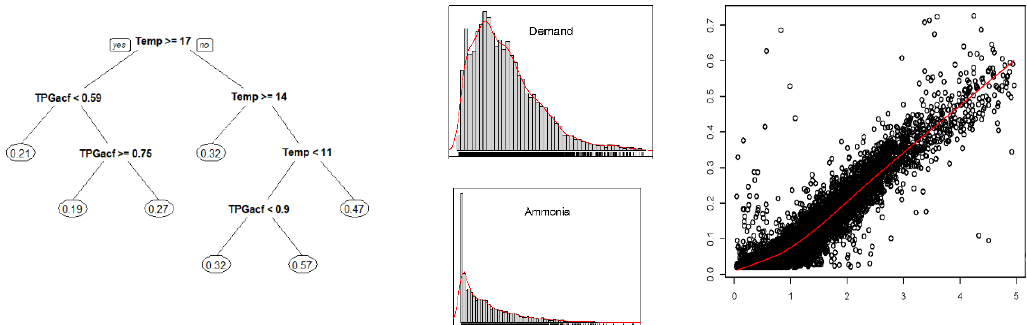
Figure 10. Left: decision tree for chlorine demand; right: correlation between ammonium concentration and chlorine demand (about R = 0.93).